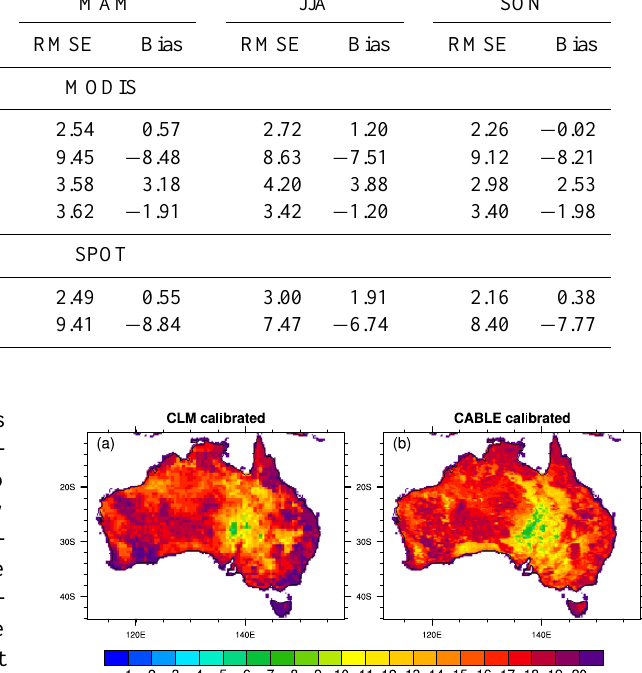
Table 7. Same as in Table 3 but for the PSALB_20C experiment. YEARLY DJF MAM JJA SON Bias RMSE Bias